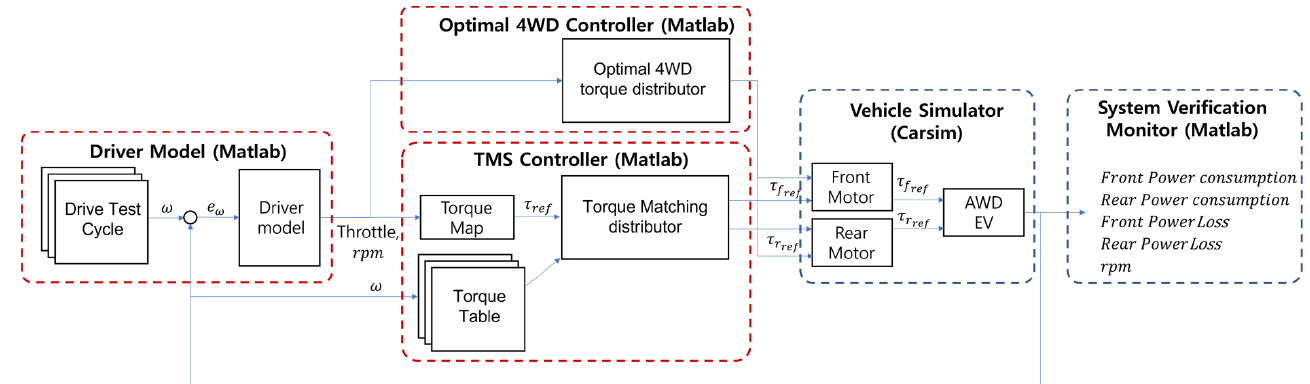
Figure 5. Simulation environment configuration for power distribution system application and Figure verification.